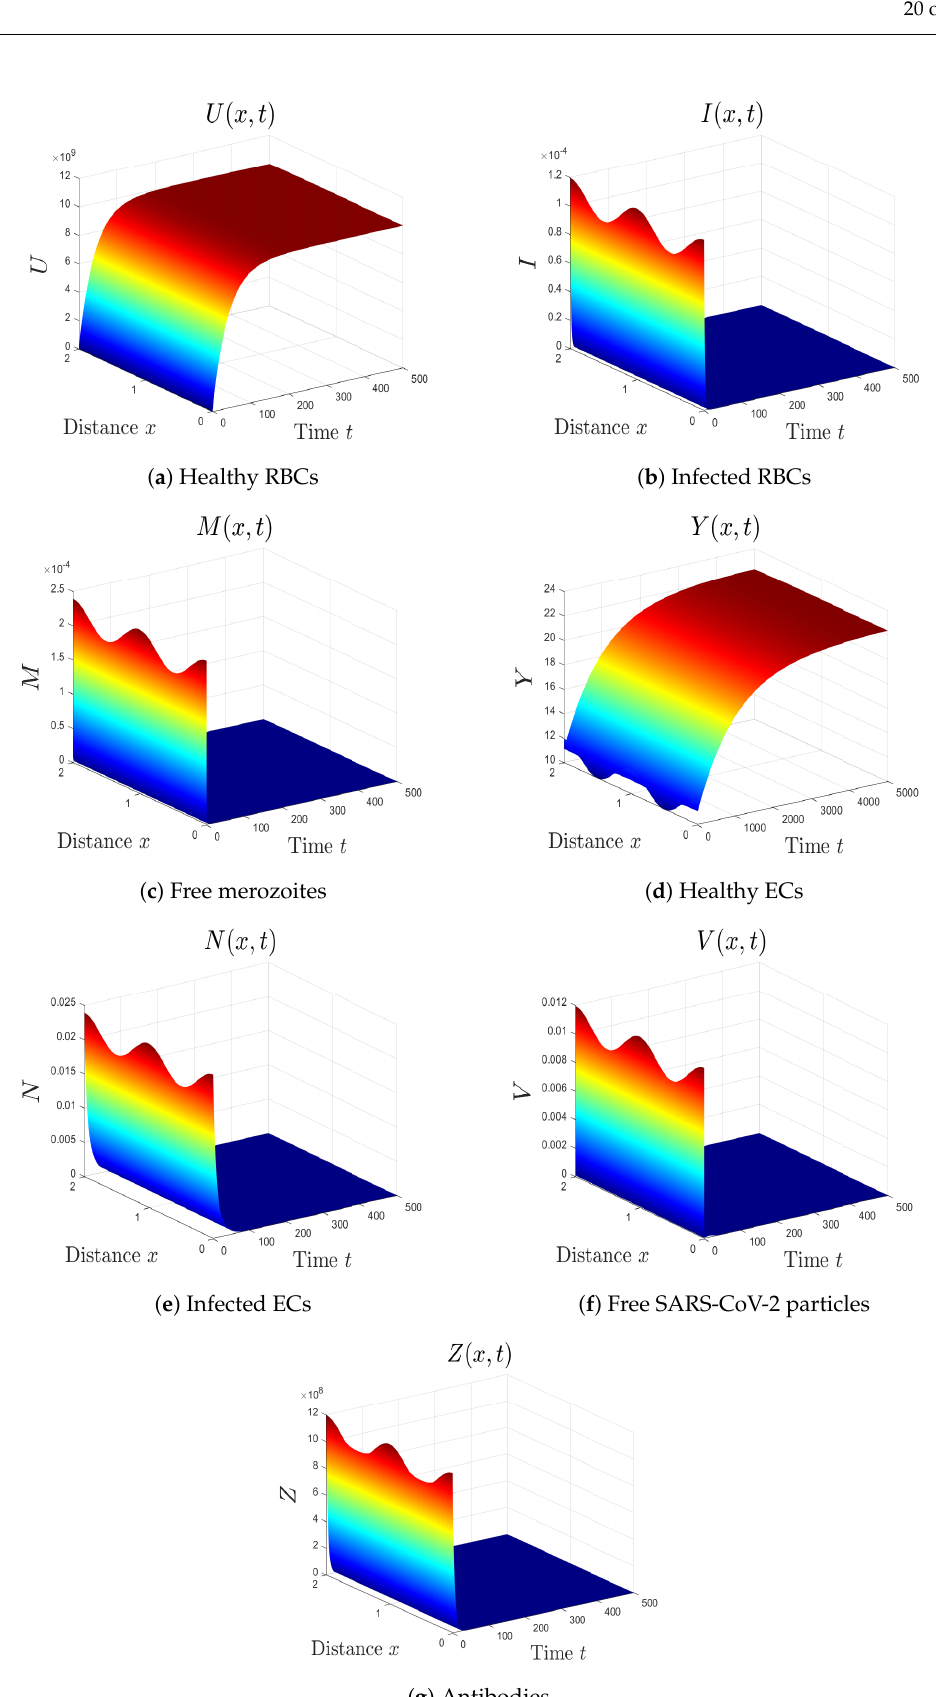
Figure 1. Simulation of system (1) for ( β m , β v , p 1 , p 2 , d 7 ) = ( 2 × 10 − 10 ,0.1,3 × 10 − 8 ,0.96,0.2 ) . The un- infected equilibrium E 0 = ( 10 × 10 9 ,0,0,22.41,0,0,0 ) is